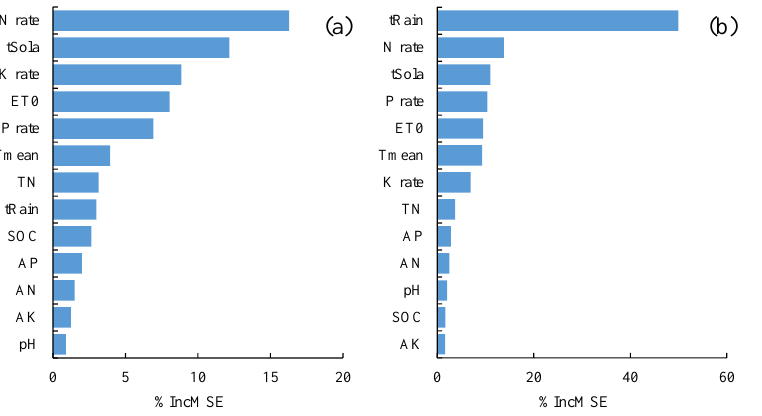
Figure 3. Predictive importance of nutrient management practices, climate condition, and soil fertility on the yield ( a ) and WP ( b ) as determined by random forest modeling.